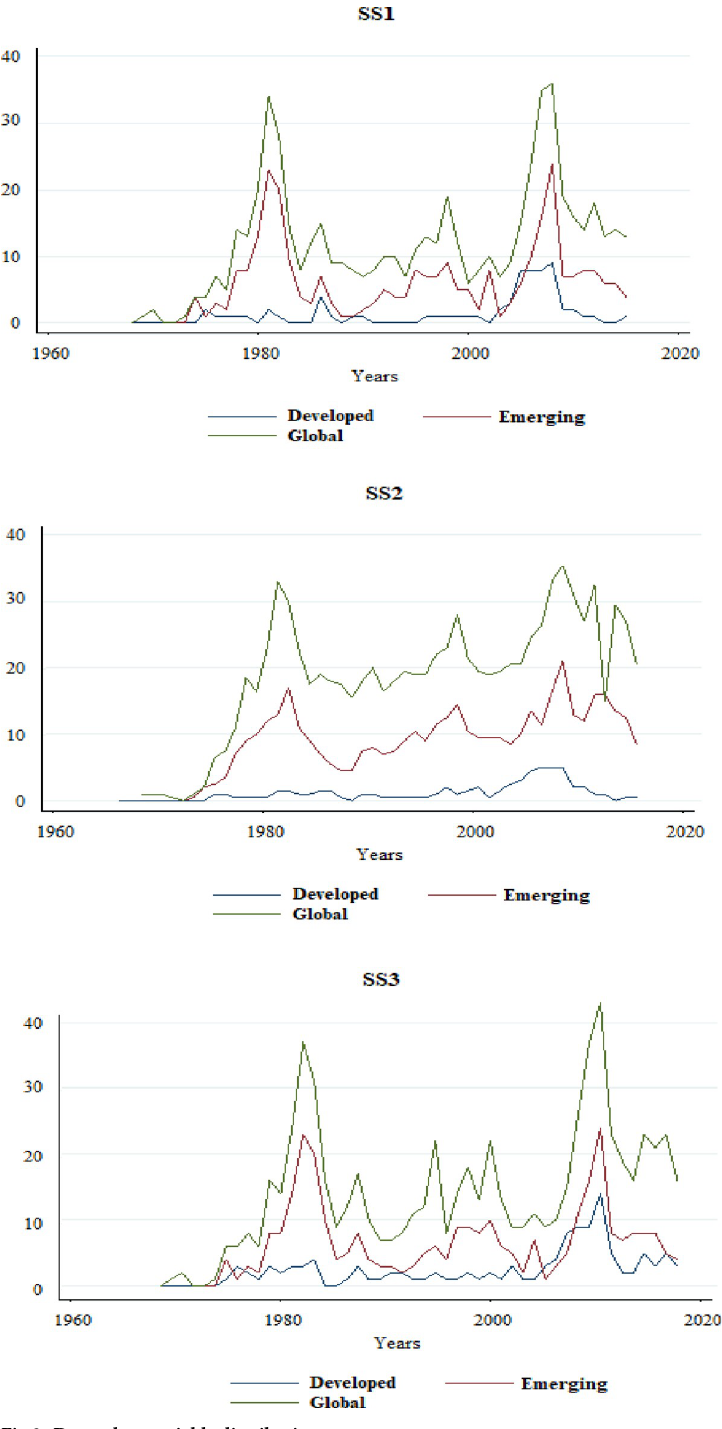
Fig 2. Dependent variable